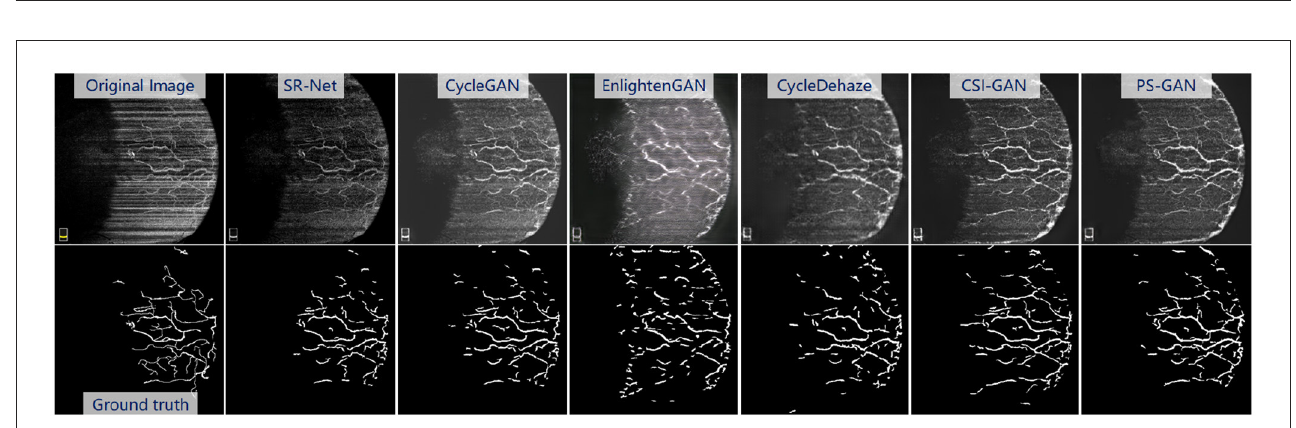
FIGURE10 Results of the re-enhancing stage with PS-GAN on an AS-OCTA image. The (top) are the re-enhancing results after SR-Net and the (bottom) are the segmentation results by COOF